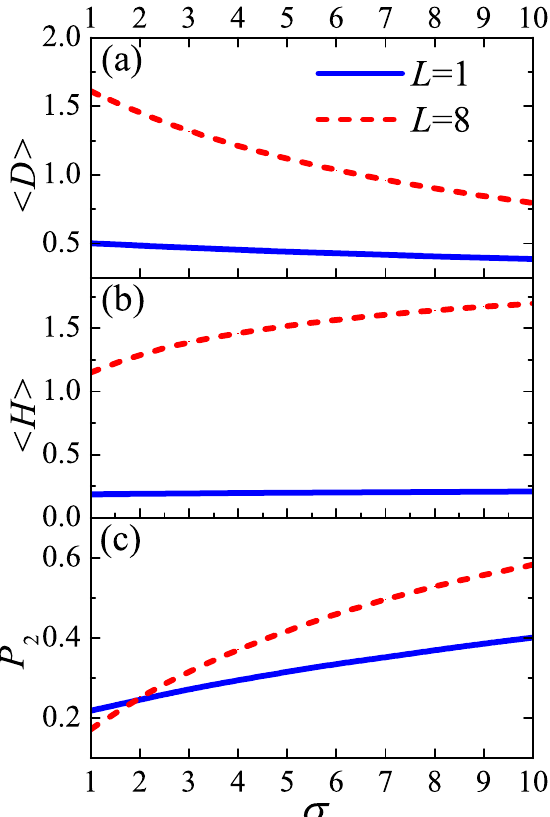
Figure 10. ( a ) The optimal average distance between two injection points of loop (cid:104) D (cid:105) , ( b ) the average thickness (cid:104) H (cid:105) , and ( c ) the segment orientation order parameter P 2 , versus the density of injection points σ varying from 1 to 10. The blue solid lines and red dash lines correspond to tight fold ( L = 1) and loose loop ( L = 8), respectively. Higher value of P 2 is corresponding to higher ordered